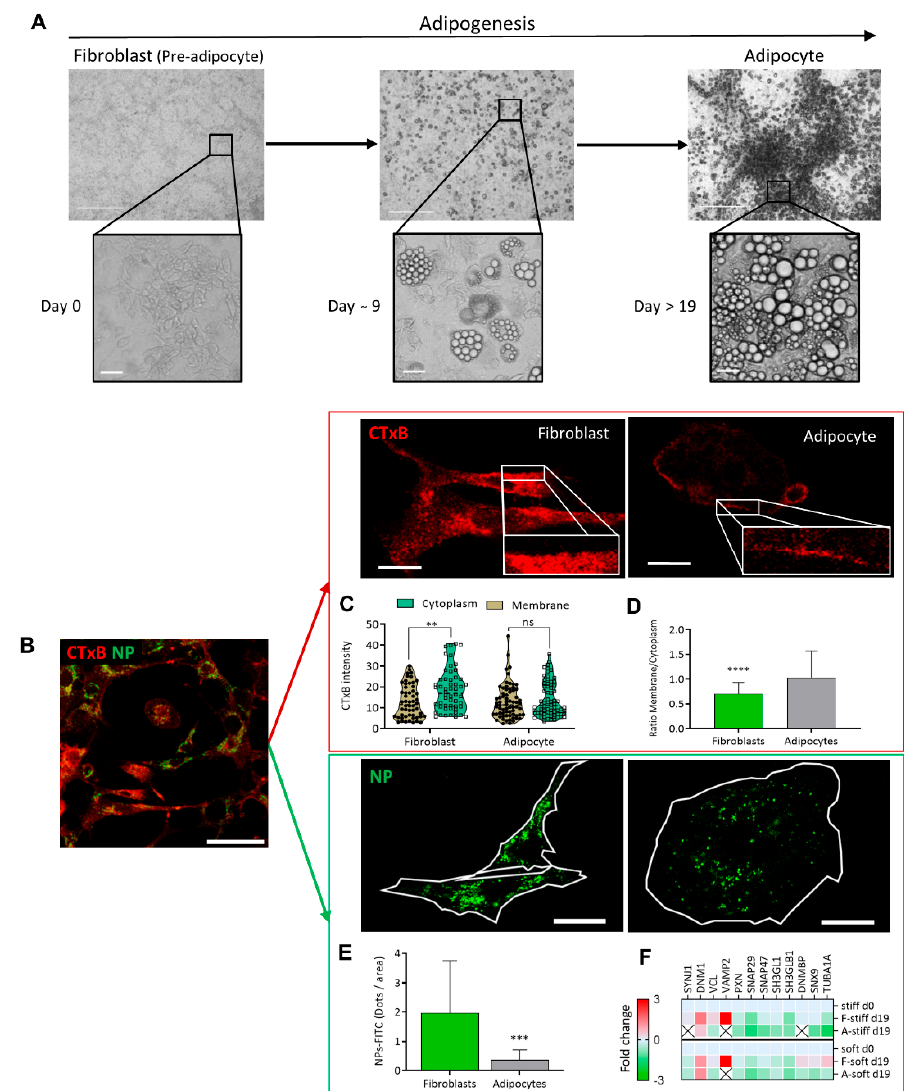
Figure 1. Endocytosis differences between fibroblast and adipocytes ( A ) Adipogenesis follow-up from fibroblast (pre-adipocyte) into adipocyte viewed by phase contrast micrograph at (×40 and ×400) magnification. Scale bar = 125 µm. ( B ) Immunofluorescence staining for the expression of CTxB binding (red) or NP-FITC (green) uptake was analyzed at single-cell resolution (B-E; scale bar = 20 µm). ( C ) CTxB intensity quantified in the cell membrane and cytoplasm of fibroblast and adipocytes. ( D ) The intensity of the membrane/cytoplasm ratio was compared between fibroblasts (n = 54) and adipocytes (n = 68). ( E ) NP–FITC internalization was measured at single cell fibroblasts (n = 16) or adipocytes (n = 18) per FOV. ( F ) Heat map from an MS/MS analysis for endocytosis- related proteins in fibroblasts and adipocytes in stiff/soft growing substrate conditions. (ns p > 0.05, ** p < 0.01, *** p < 0.001, **** p <